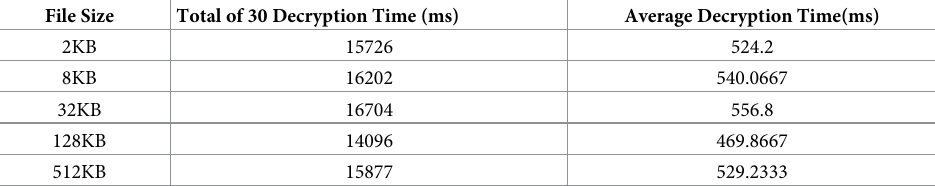
Table 4. The proposed total decryption and average decryption time of NCS.